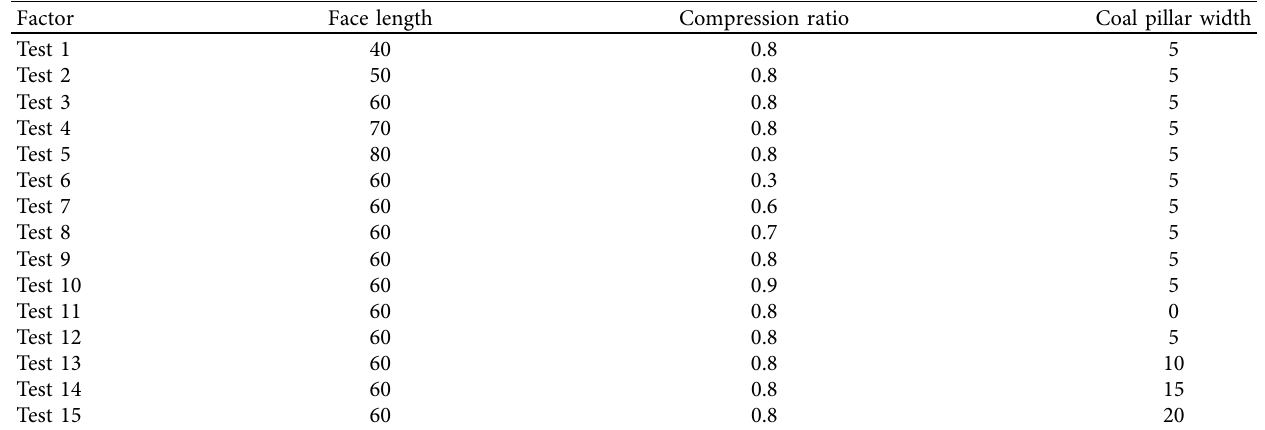
Figure 6: CORS base station and measuring points at Tangshan mine. Table 1: Description of test plans.